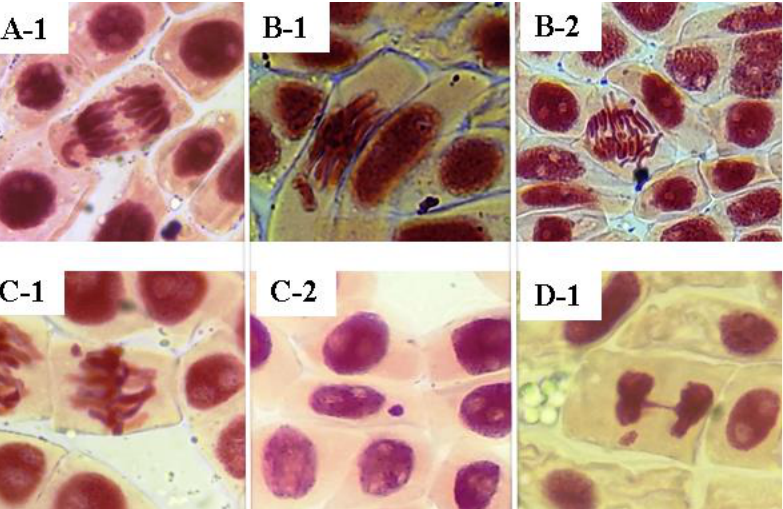
Figure 6. Chromosomal aberrations caused by the fraction from A. muricata seeds. Source: Author, 2022. ( A-1 ): Wandering chromosomes; ( B-1 – 2 ): chromosomal loss; ( C-1 – 2 ): micronuclei; ( D-1 ): telophase bridge.